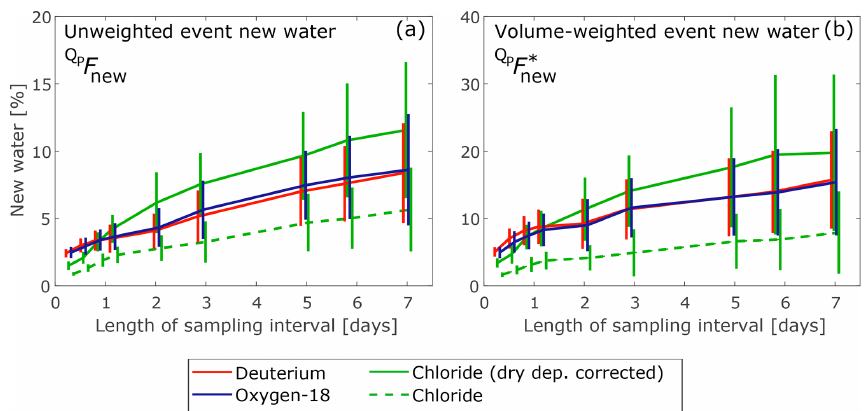
Figure 9. Effects of aggregating 7-hourly data to longer sampling intervals for deuterium (red), oxygen-18 (blue), and chloride (green) with and without correction for dry deposition effects. Error bars indicate 1 standard error. The new water fractions determined from the stable water isotopes are nearly identical, whether unweighted (a) or volume-weighted (b) . Sampling interval lengths have been slightly jittered for better visibility of the different